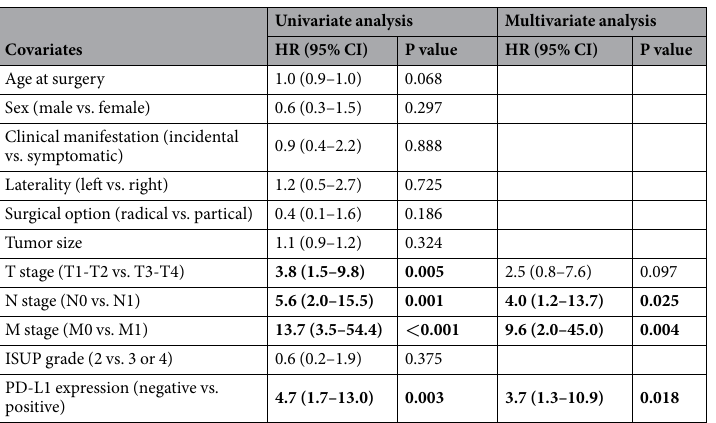
Table 2. Univariate and multivariate Cox regression analyses of PFS in 36 enrolled adult Xp11.2 RCC patients. PFS, Progression-free survival; Xp11.2 RCC, Xp11.2 translocation renal cell